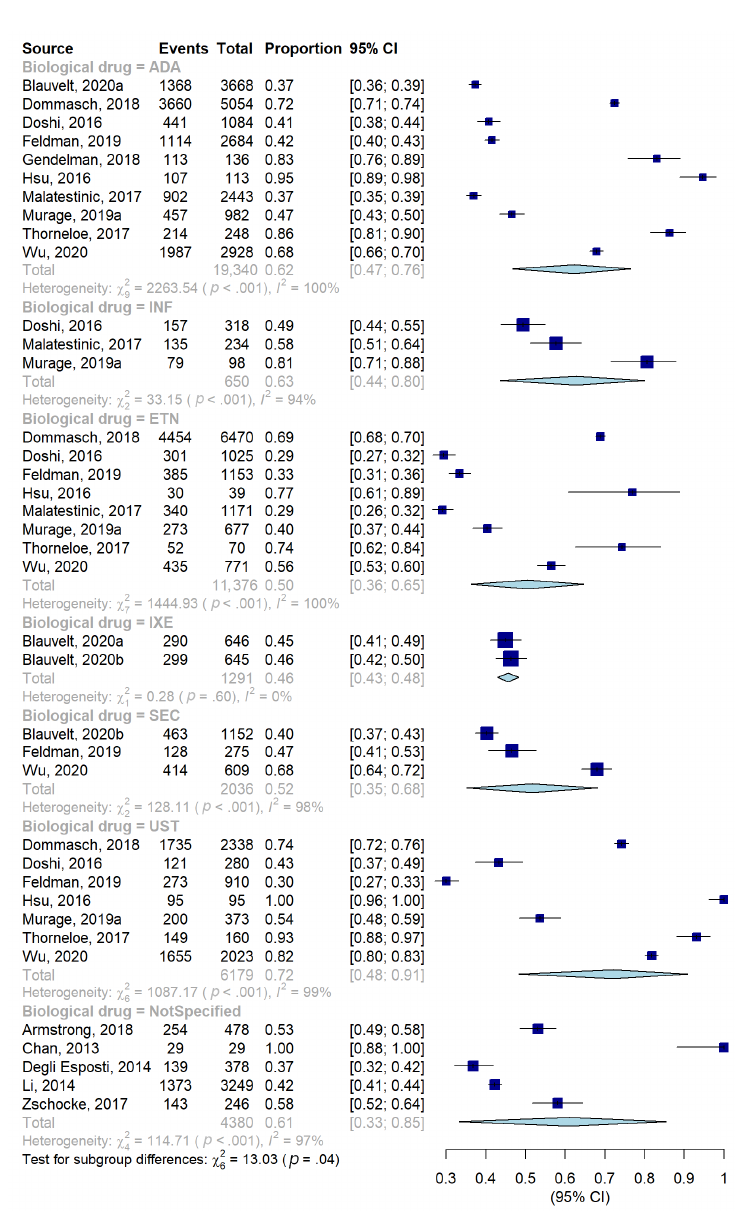
studies had a cross-sectional design in contrast with 13 retrospective cohort studies. There were no differences stratifying by biological-naïve patients and not-specified patients ( p - value = 0.24) (Table 2 and Figure S3) or stratifying by risk of bias ( p -value = 0.40) (Figure S4). 3.3.2. Persistence The meta-analysis conducted on 46 studies including 156,801 patients showed a per- sistence proportion of 63% (57–68, Figure 5), with considerable heterogeneity (I 2 = 100%). Less than half of the studies (19 out of 46) reported the reasons for drug discontinuation or switching. The most common reasons were loss of efficacy and adverse events (nine studies) followed by ineffectiveness (three studies). Qualitative descriptions of the reasons are shown in Table S3.